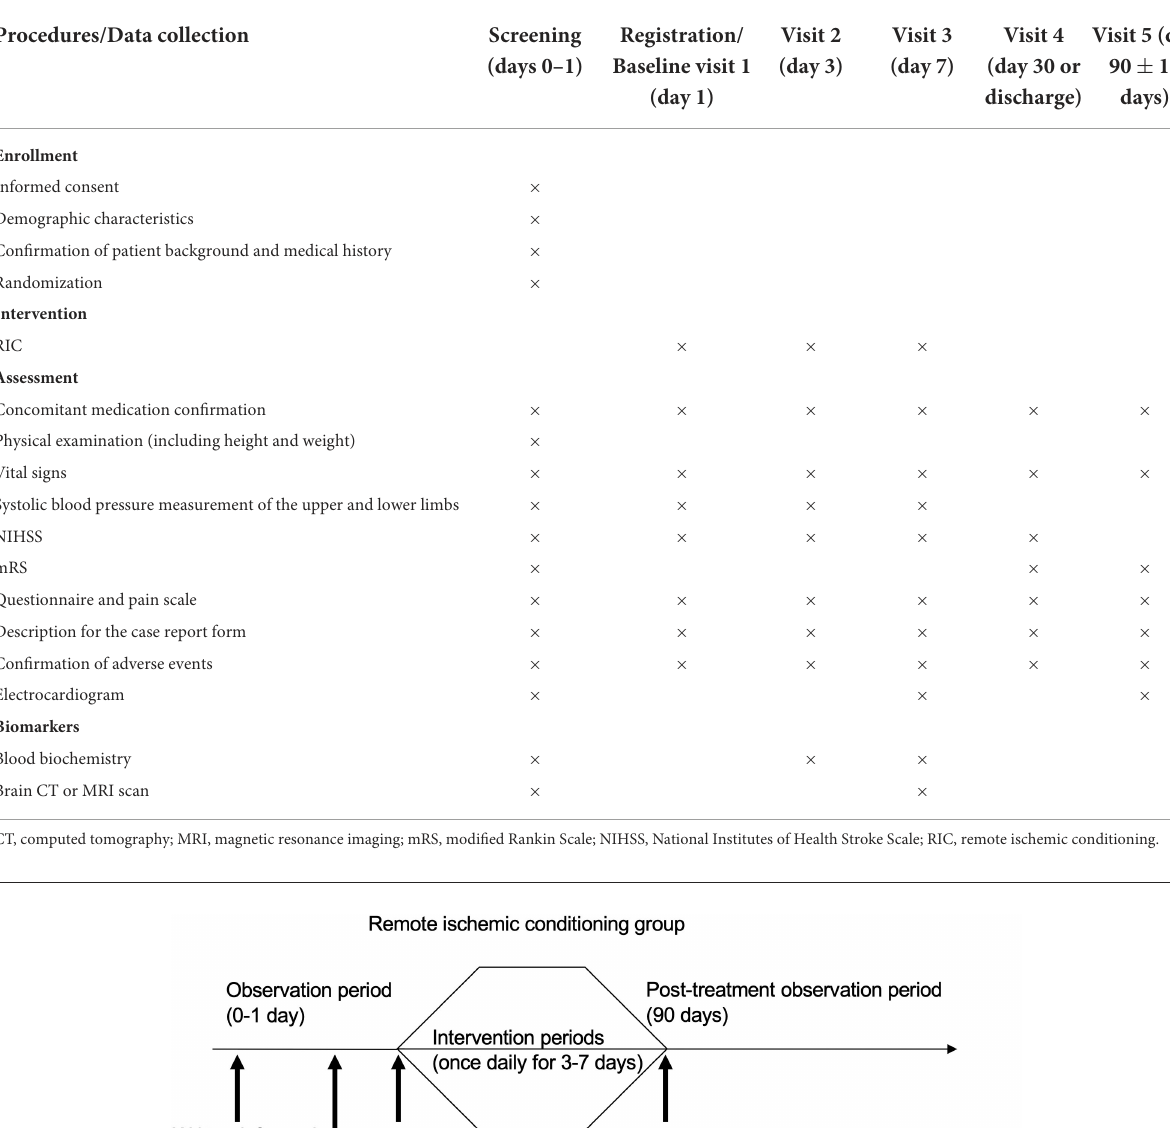
TABLE 2 Study procedures for eligible patients with acute ischemic stroke.